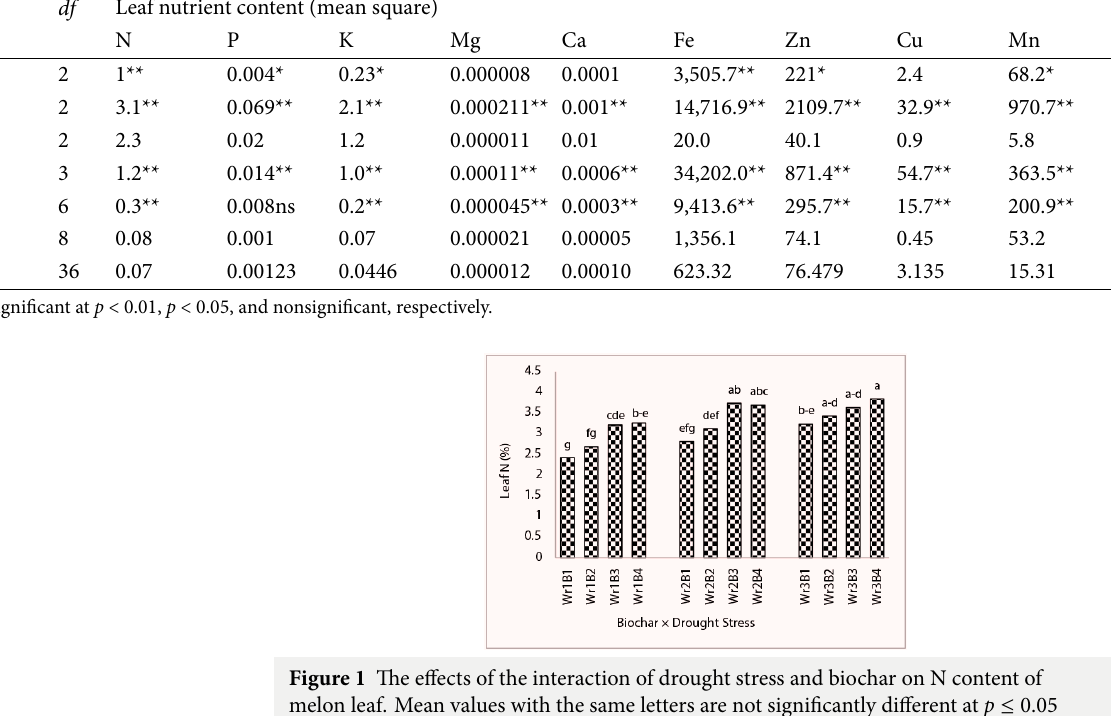
Table 6 Analysis of variance (ANOVA) for the effect of biochar on leaf nutrient content of melon plants under drought stress. Source of variance